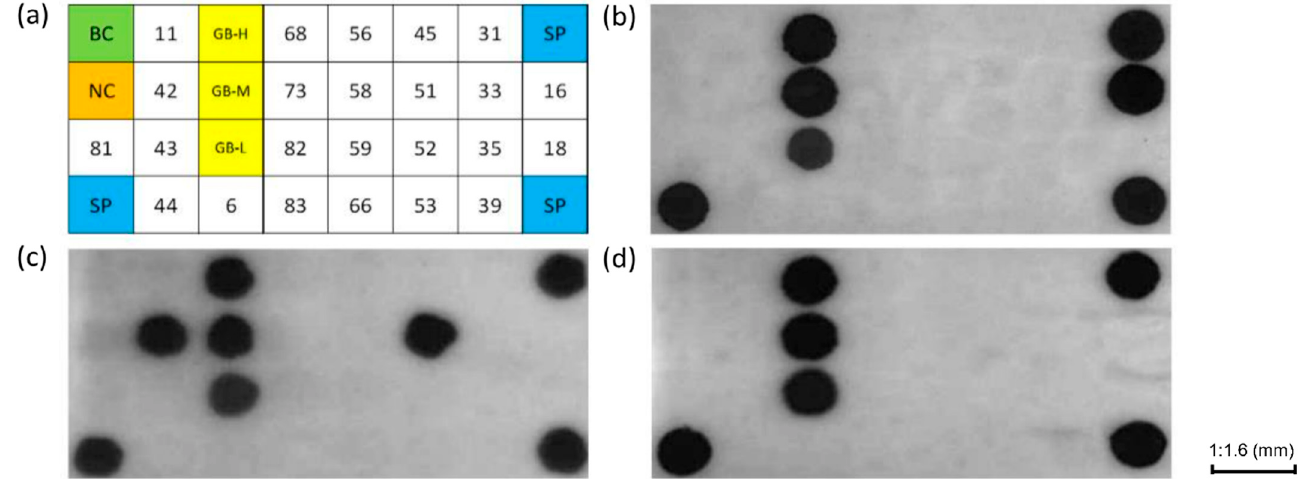
Figure 2. Microarray design and example of test results. ( a ) Illustration of probes distributed on a microarray, including 1 Blank control (BC, green area), 1 Negative control (NC, orange area), 3 internal reference control (GB, yellow area) with different concentrations, 3 Spot control (SP, blue area), HPV probes of 24 genotypes (18 hrHPV probes:16, 18, 31, 33, 35, 39, 45, 51, 52, 53, 56, 58, 59, 66, 68, 73, 82, 83; 6 lrHPV probes:6, 11, 42, 43, 44, 81. white area). ( b ) HPV16 positive results; ( c ) HPV42, 51 double-points positive results, ( d ) Negative result.